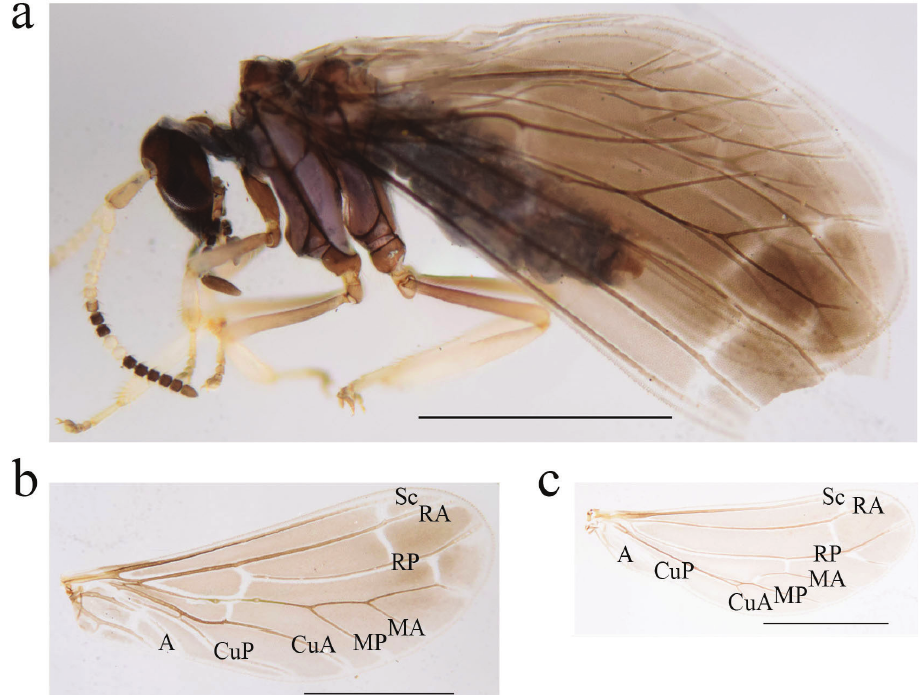
Figure 1. Heteroconis orbicularis sp. nov., holotype male a habitus, lateral view b head, dorsal view c fore- wing d hindwing. Scale bar: 1